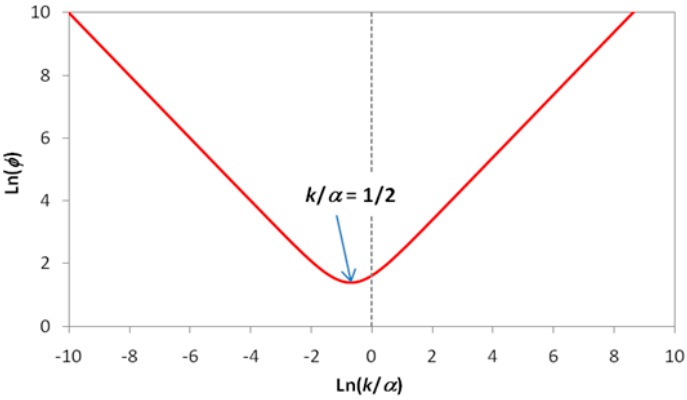
Figure 7. Dependence relationship of wave scattering factor on the incident waves and pipe diameter non-uniformities.